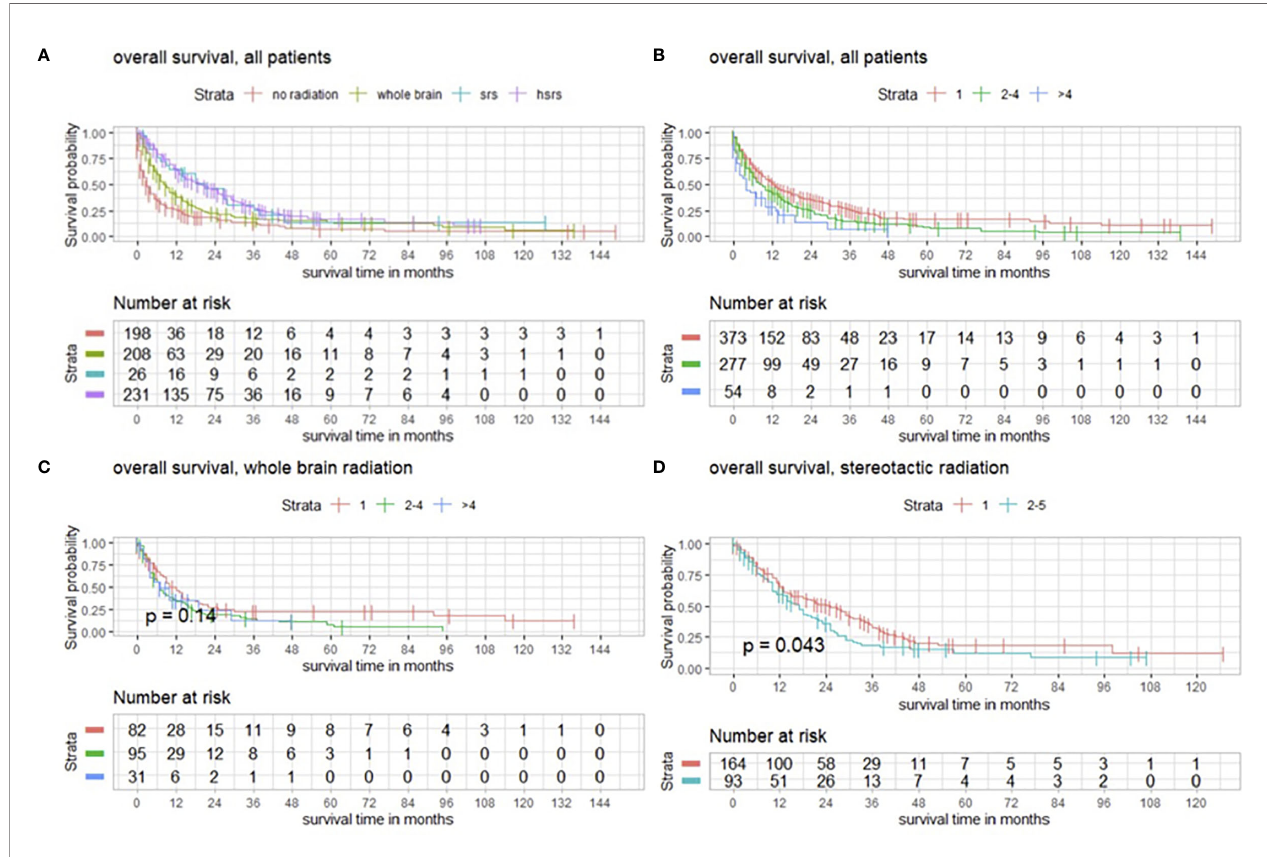
FIGURE 4 | (A) Overall survival of patients with operated BMs with and without postoperative radiotherapy modeled by Kaplan – Meier estimates. (B) Survival functions according to number of BMs in favor of single BM. (C) Functions of overall survival in subgroups with WBRT and number of BMs demonstrating no signi fi cantly divergent survival curves ( p = 0.14), and (D) survival estimates in patients with postoperative SRS signi fi cantly divergent in favor of patients with a single BM ( p =